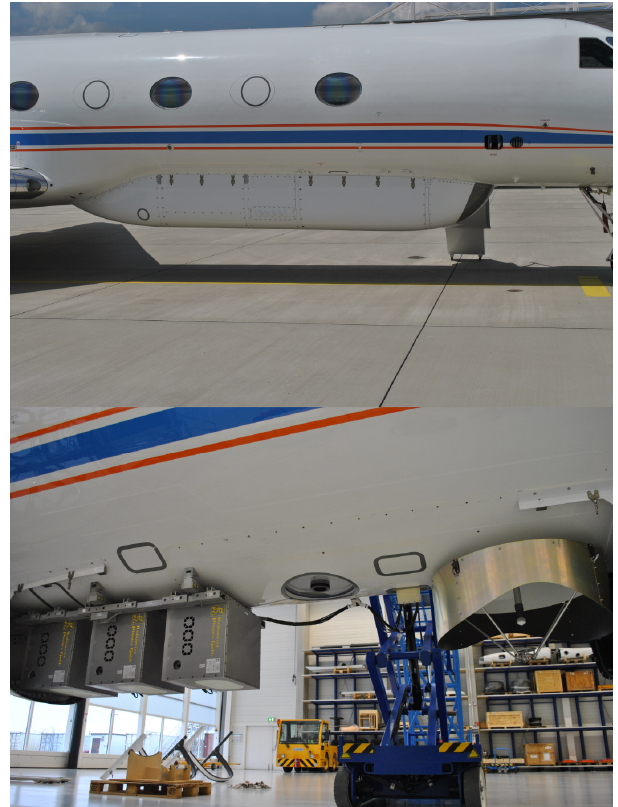
Figure 1. Top: closed belly pod mounted on HALO. Bottom: re- mote sensing instruments underneath the body of HALO (from left to right: HALO-G, HALO-KV, and HALO-WF module; lidar win- dow; and cloud radar MIRA-36